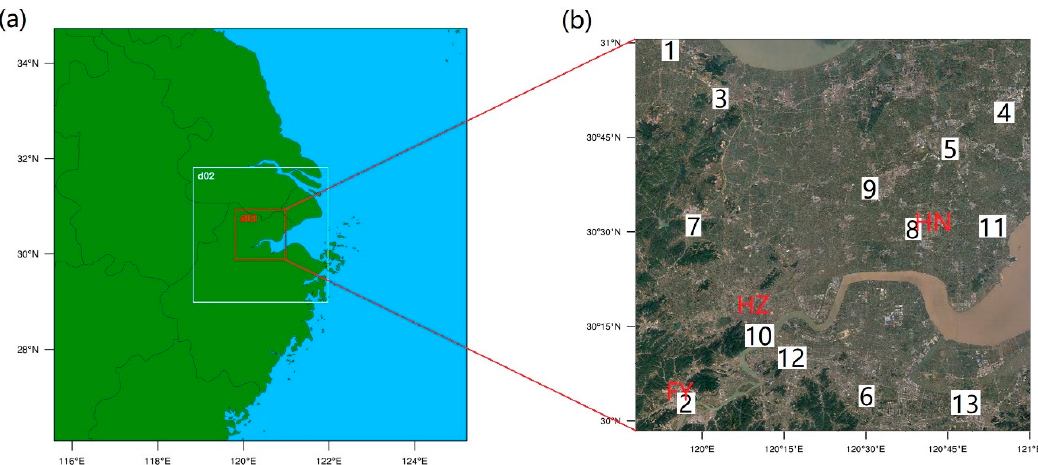
Figure 1. Study area ( a ) model domains d01, d02, and d03, with 9, 3, and 1 km horizontal resolution, respectively; and ( b ) Hangzhou (HZ), Haining (HN), Fuyang (FY), and 13 China Meteorological Administration (CMA) observation sites (numbers). (Source of base maps: Google Timelapse [20]).